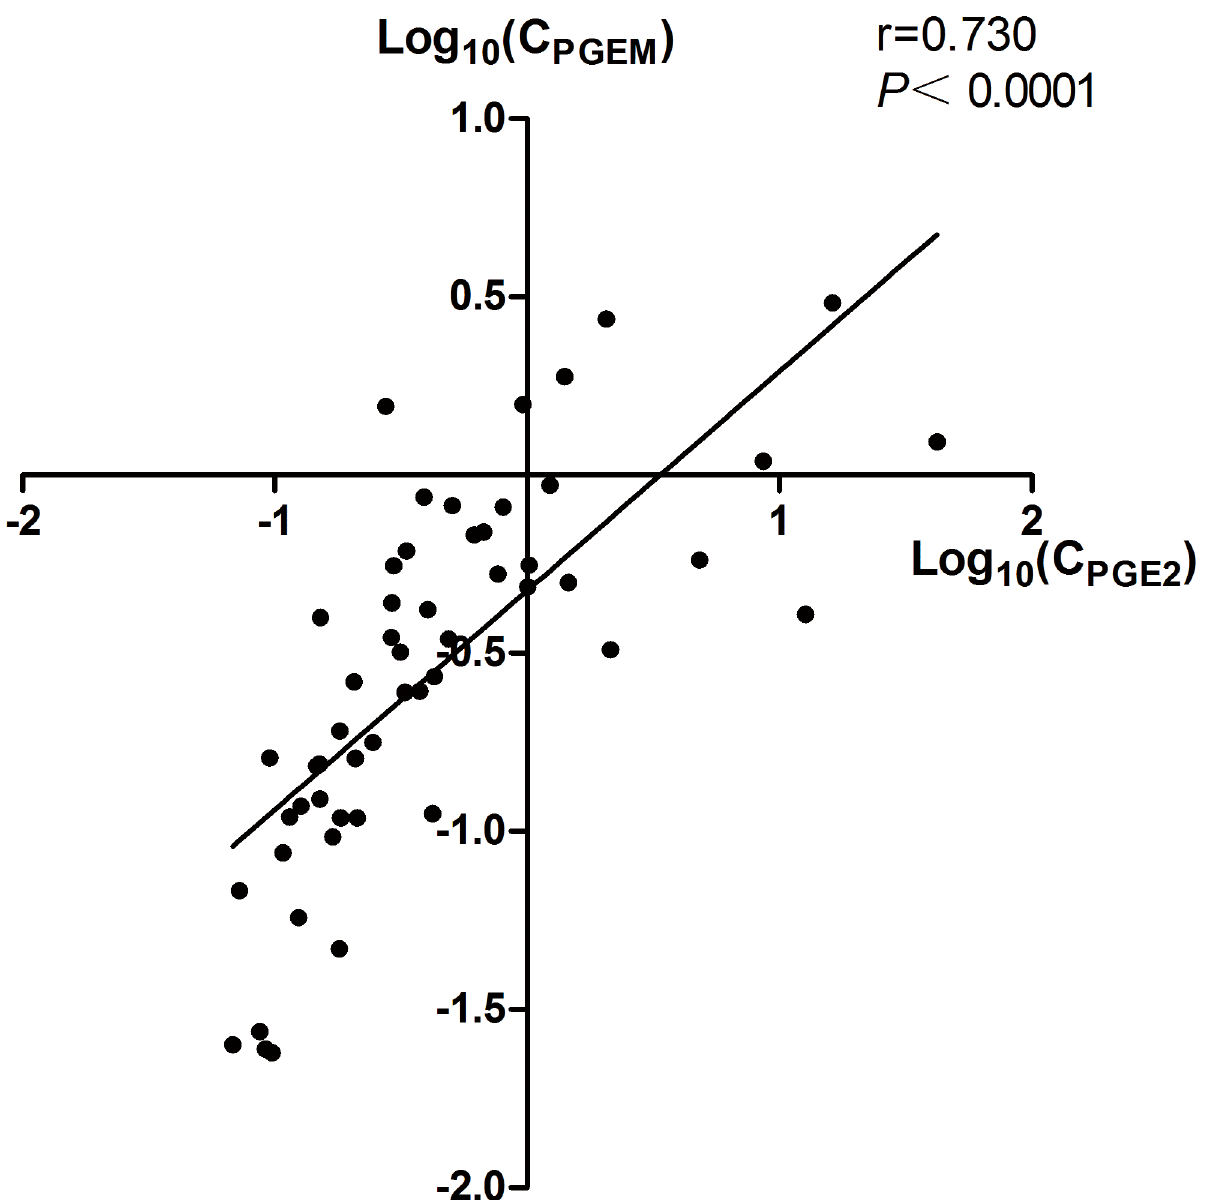
Fig 2. Individual urinary prostaglandin E2 (PGE2) and PGE metabolite (PGEM) levels (33 GS patients and 20 healthy controls; log transformed). Urinary PGEM and PGE2 levels showed a good correlation(r = 0.730, P < 0.001).Abbreviations: C PGEM , 24h urinary prostaglandinE2 metaboliteconcentration; C PGE2 , 24h urinary prostaglandinE2 concentration.